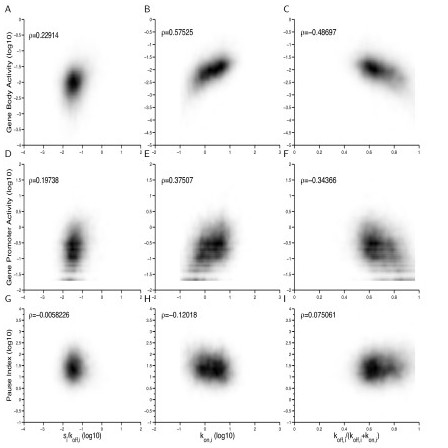
Correlation of transcriptional kinetics with RNA polymerase II binding in mouse ES cells. In the left panel, burst size (or transcriptional efficiency) is plotted on the x-axis. In the middle panel, burst frequency is plotted on the x-axis. In the right panel, the average fraction of time that a gene spends in the inactive state is plotted on the x-axis. In all the panels, the following are plotted on the y-axis: the gene body activity (A)-(C), the gene promoter activity (D)-(F), and the pause index (G)-(I). Each point represents one identifiable gene with a normalized read count greater than 50 in at least one cell. ρ is the Spearman correlation coefficient.